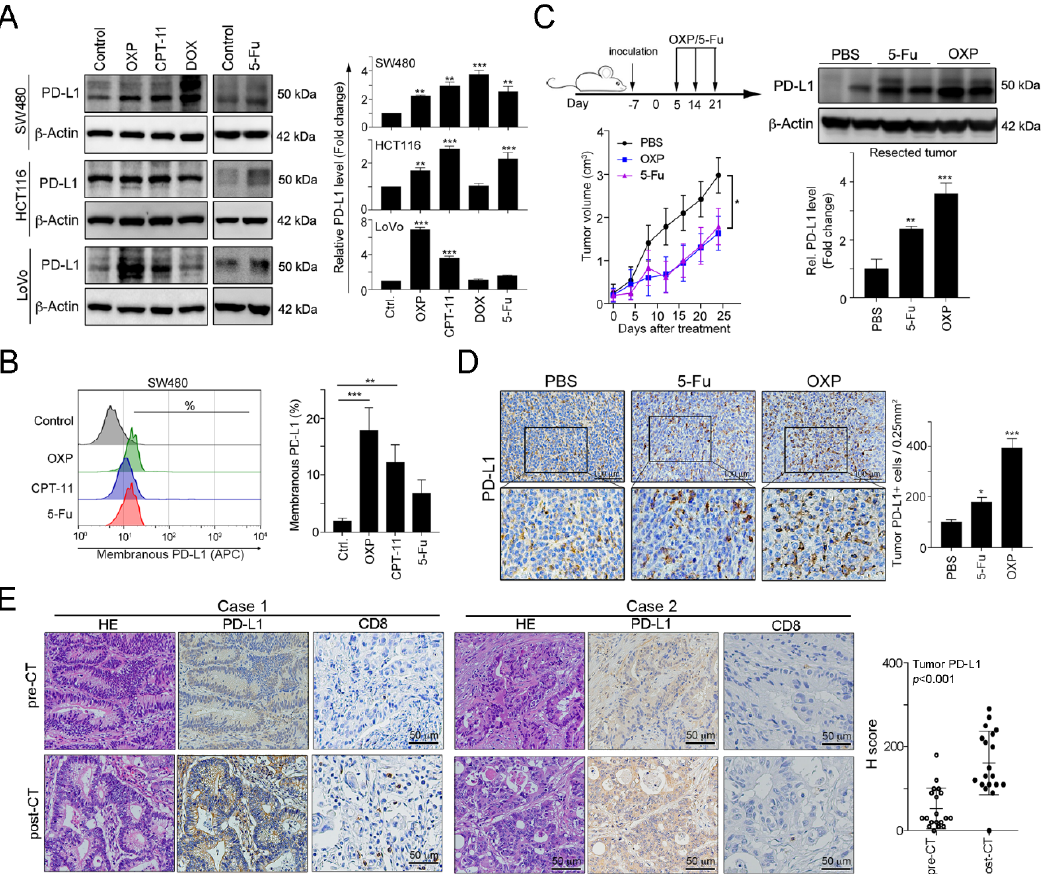
Figure 1. FOLFOX-based preoperative neoadjuvant chemotherapy significantly upregulated the tumor programmed cell death 1 ligand 1 (PD-L1) level. ( A ) The SW480, HCT116 and LoVo colorectal cancer cell lines were treated with oxaliplatin (OXP, 10  M), irinotecan (CPT-11, 5  M),